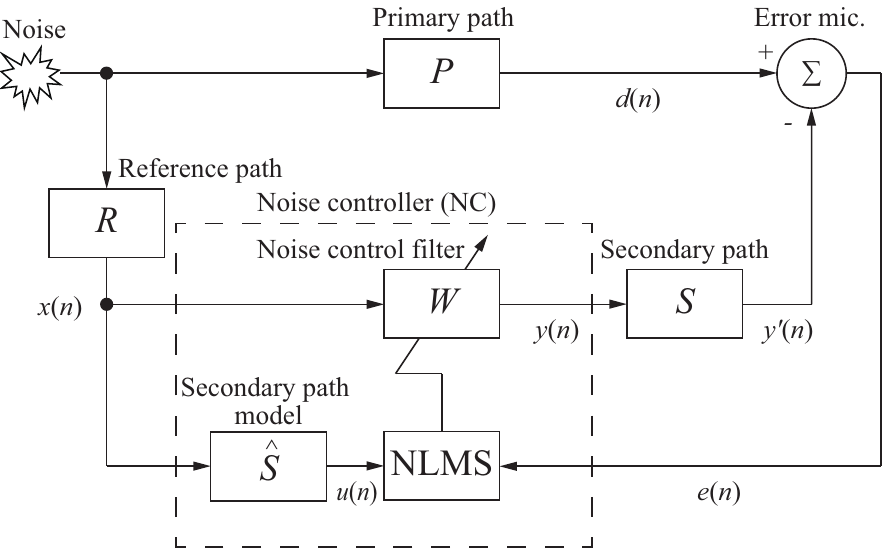
Figure 1. Block diagram of a single-channel feedforward active noise control (ANC)